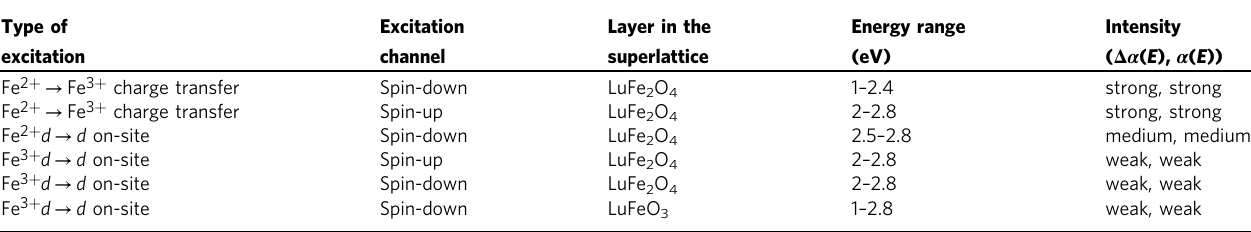
The fi rst three rows indicate the most important excitations as discussed in Supplementary Information. The energy range for our measurements is from 0.8 - 2.8